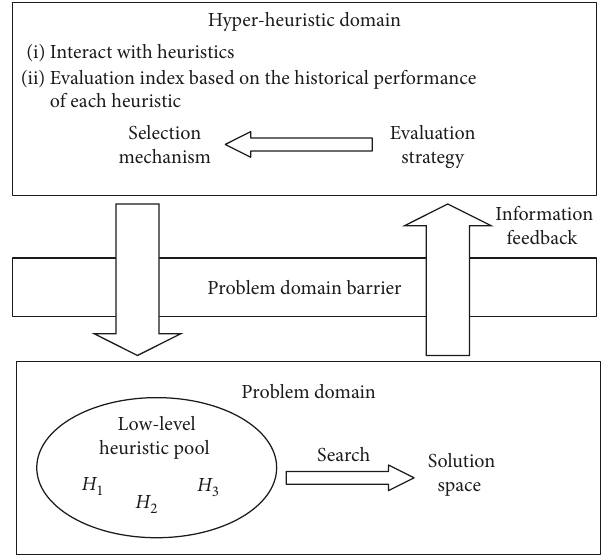
Figure 1: Framework of the proposed selection hyper-heuristic